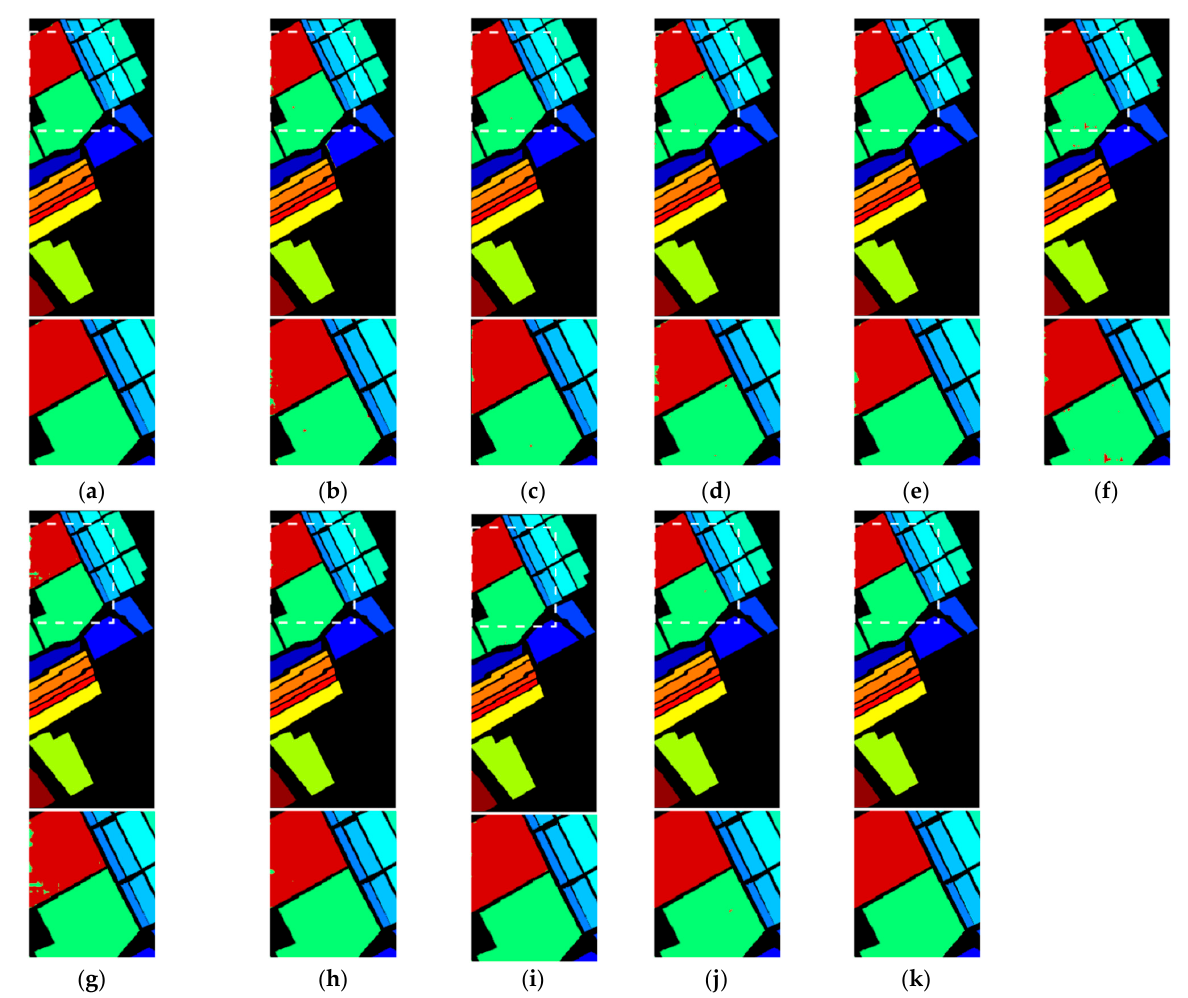
Figure 9. Classification maps generated by HybridSN using different BS methods for the Salinas dataset: ( a ) Full bands; ( b ) UBS; ( c ) OMP-BS; ( d ) PBS; ( e ) FNGBS; ( f ) SQ CCBSS; ( g ) LCMV-BSS; ( h ) SC SSRBSS; ( i ) SQ FNG-SSRBSS; ( j ) SQ BD-SSRBSS; ( k ) Ground truth.